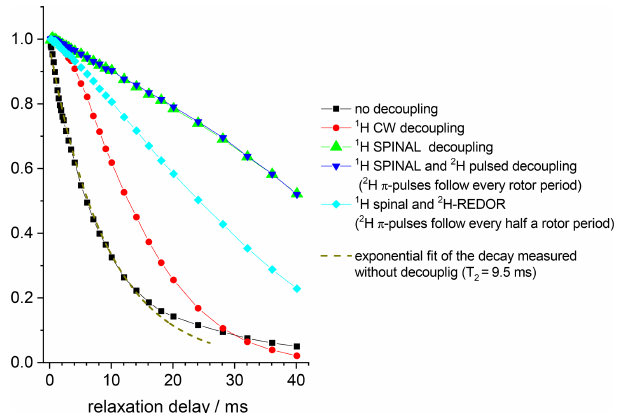
Figure 10. 15 N Hahn-echo decays measured in GB1 protein sample at different 1 H and 2 H decoupling schemes. MAS 20kHz, t 13 ◦ C, 1 H decoupling strength (both for CW and SPINAL) 130kHz, dura- tion of 2 H π pulses 10.5µs.